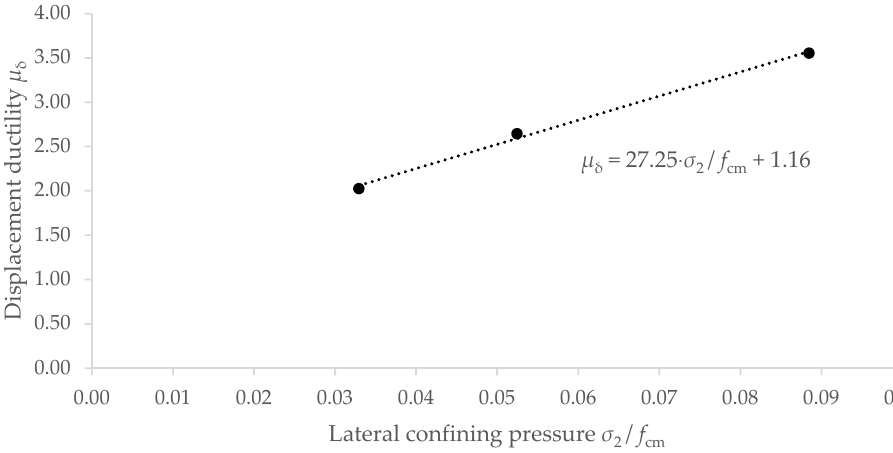
Figure 8. Influence of confinement on displacement ductility.